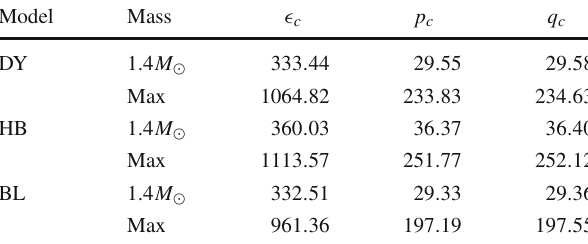
Table 1 Comparison of energy density, radial and tangential pressure in the center of anisotropic NSs where the unit is in MeV fm − 3 Model